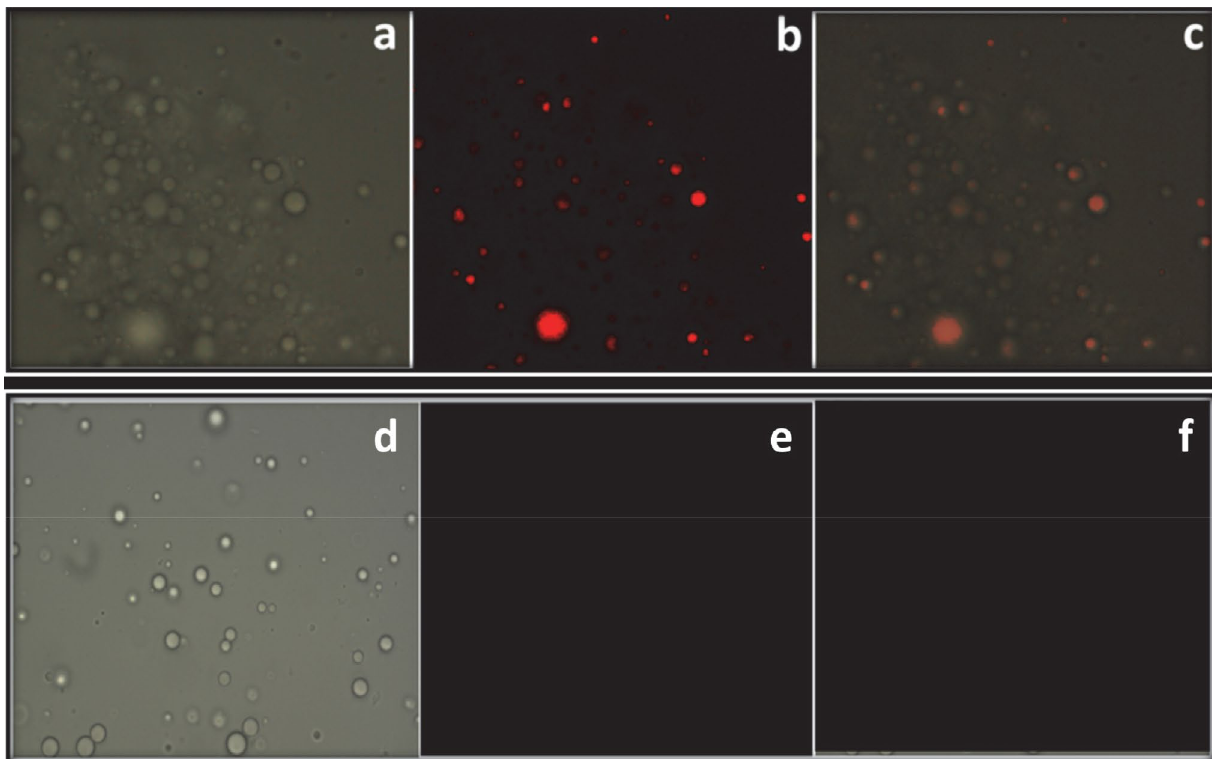
Fig. 9. Fluorescence images of Al 3+ using probe SK-1 in MCF7: (a) bright field image of MCF7 cells treated with probe SK-1 ; (b) fluorescence image of MCF7 cells treated with probe SK-1 ; (c) merged image of (a) and (b); (d) bright field image of MCF7 cells treated with probe SK-1 without Al 3+ ; (e) fluorescence image of MCF7 cells treated with probe SK-1 without Al 3+ ; (d); (f) merged image of (d) and